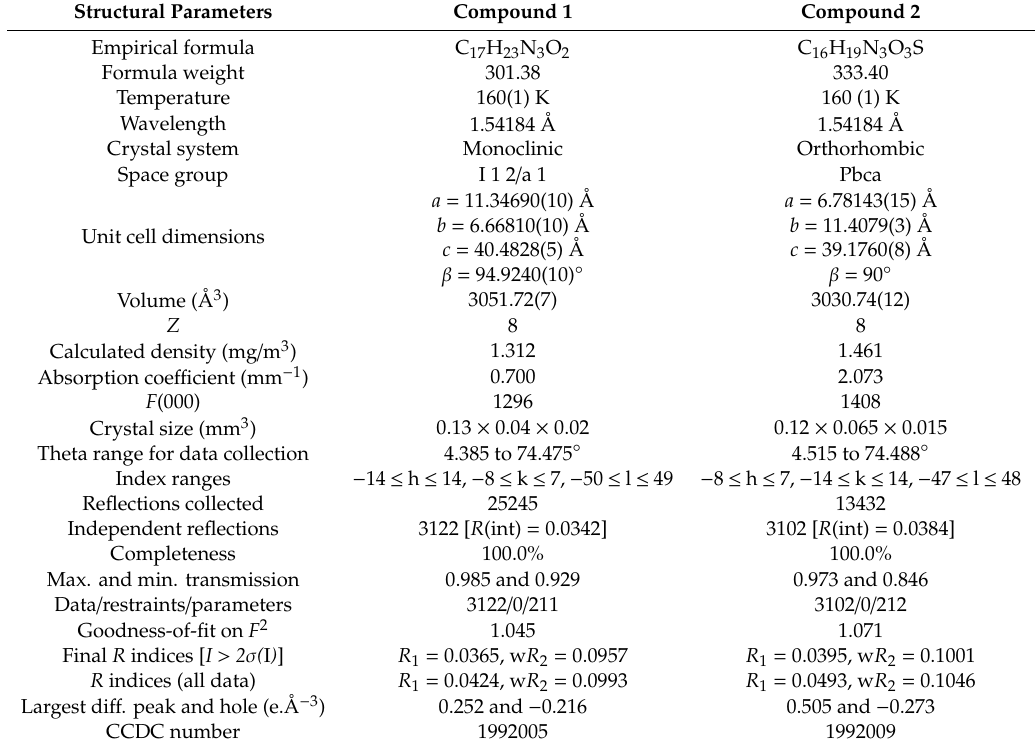
Figure 1. ORTEP diagrams at 50% probability for the asymmetric units of 1 ( a ) and 2 ( b ) with atom numbering scheme. Table 1. Crystal data and structure refinement parameters of compounds 1 and 2 .